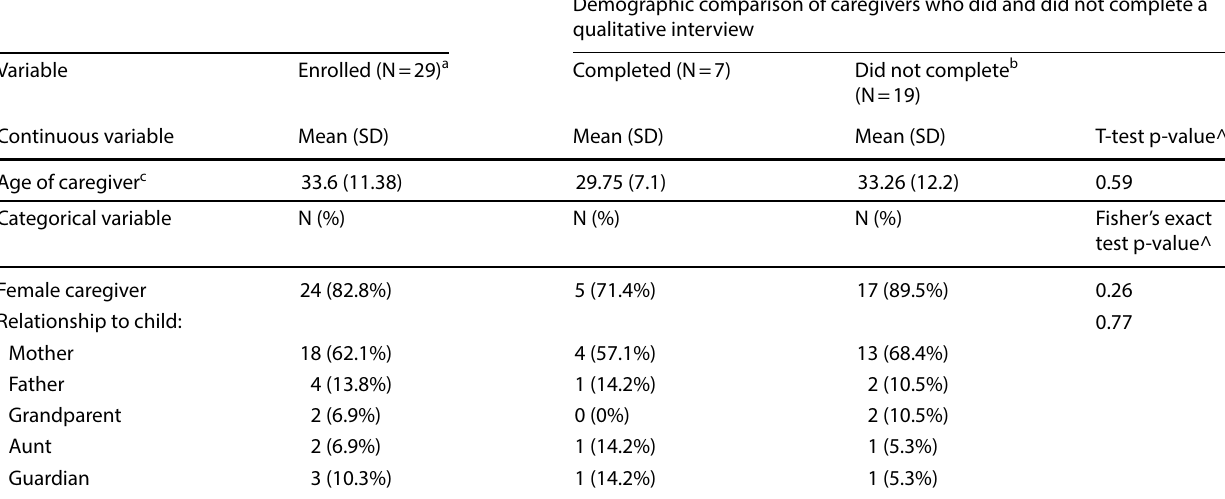
^Significant if p < 0.05. No comparisons had p <